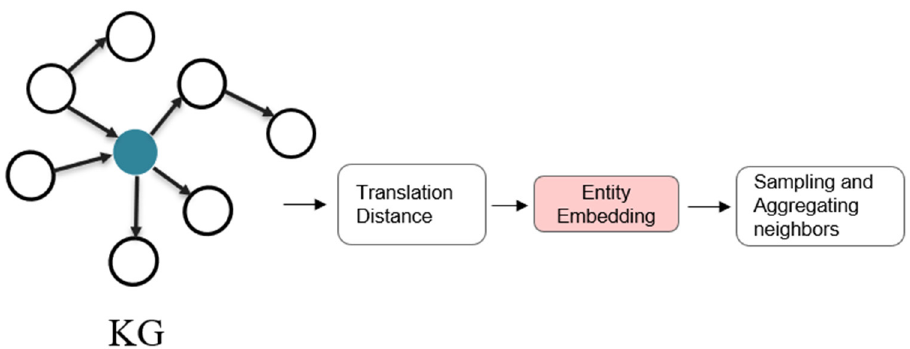
Figure 4. The knowledge graph embedding process of RotateS2F.